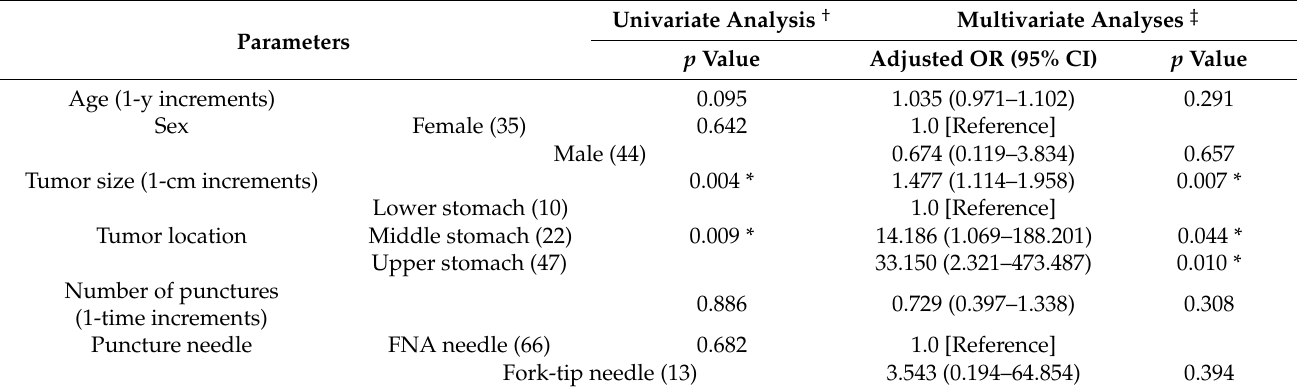
Table 4. Analyses of factors influencing diagnostic accuracy of